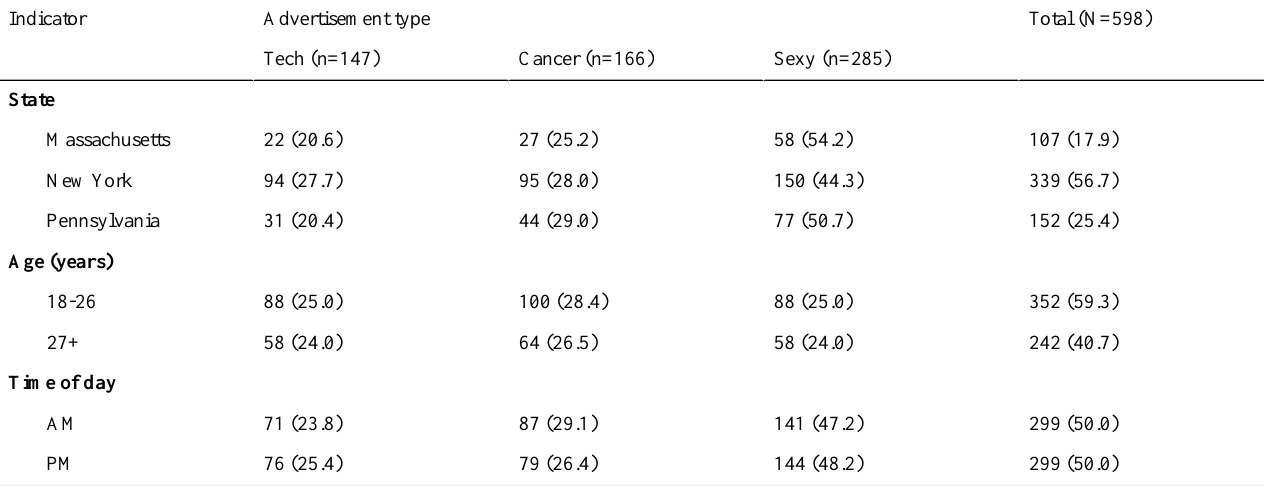
Table 2. Characteristics (state of residence, age, and time of day of click) for men who completed the eligibility survey by advertisement